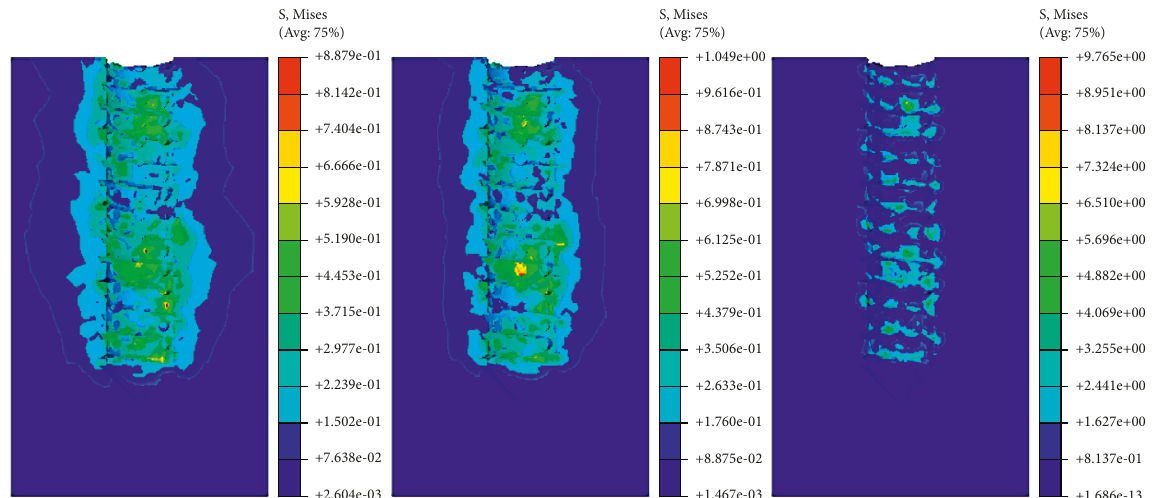
Figure 4: Contour of stresses on the bone in 0.07, 0.88, and 1 seconds.